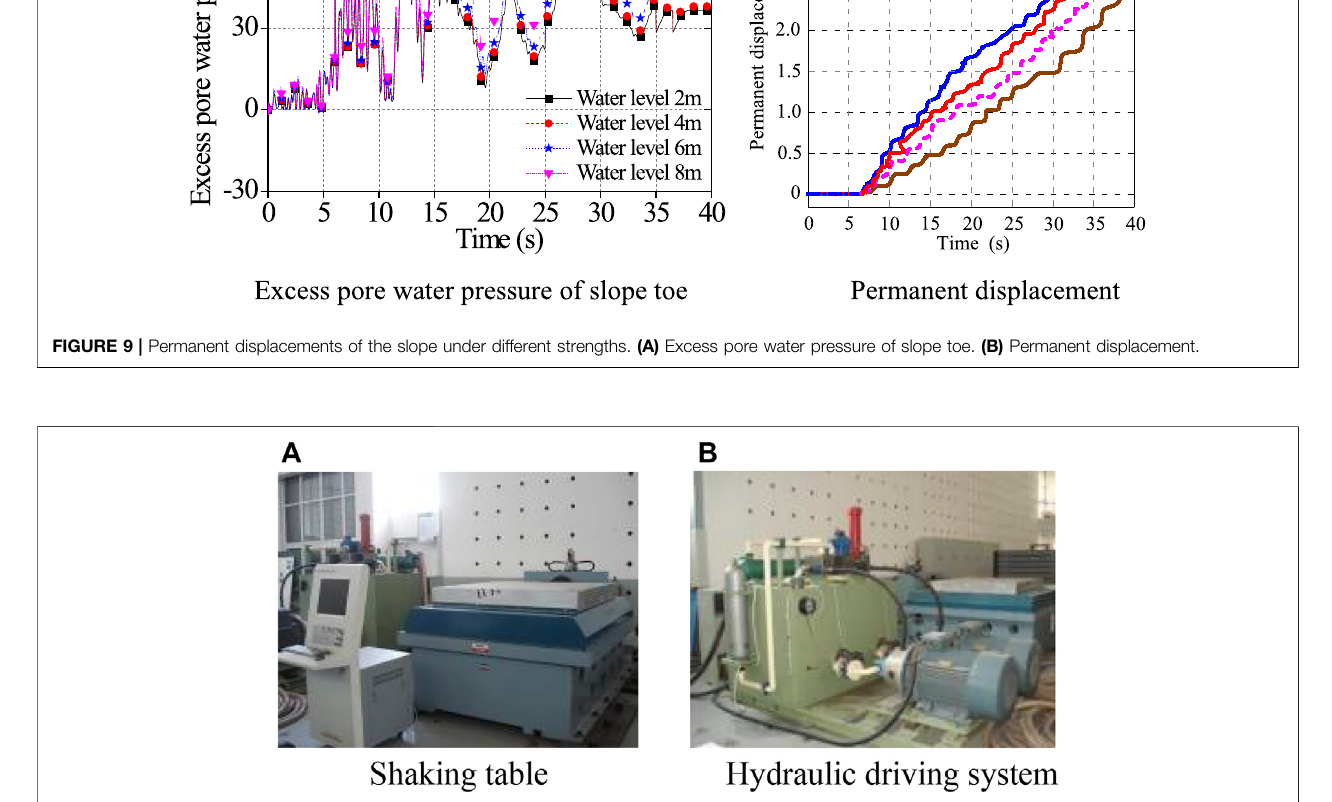
FIGURE 10 | Shaking table system. (A) Shaking table. (B) Hydraulic driving system.